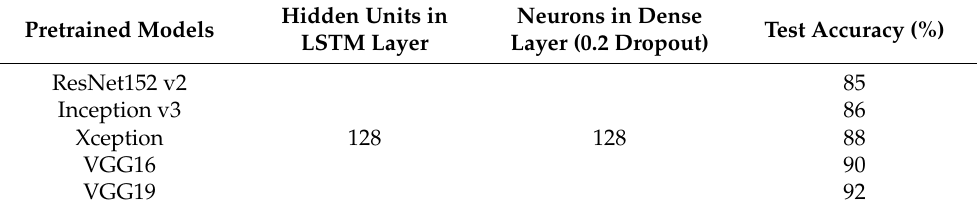
Table 4 . Performance comparison of some pretrained models on the TBSV dataset.